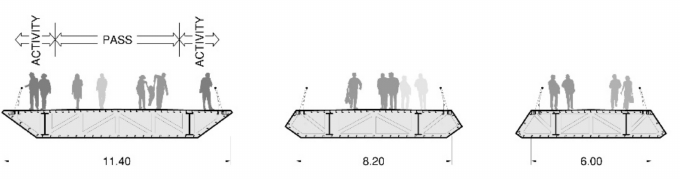
Figure 12. Deck’s cross-sections at different instances: from left to right, entry points, quarter of span, and at the